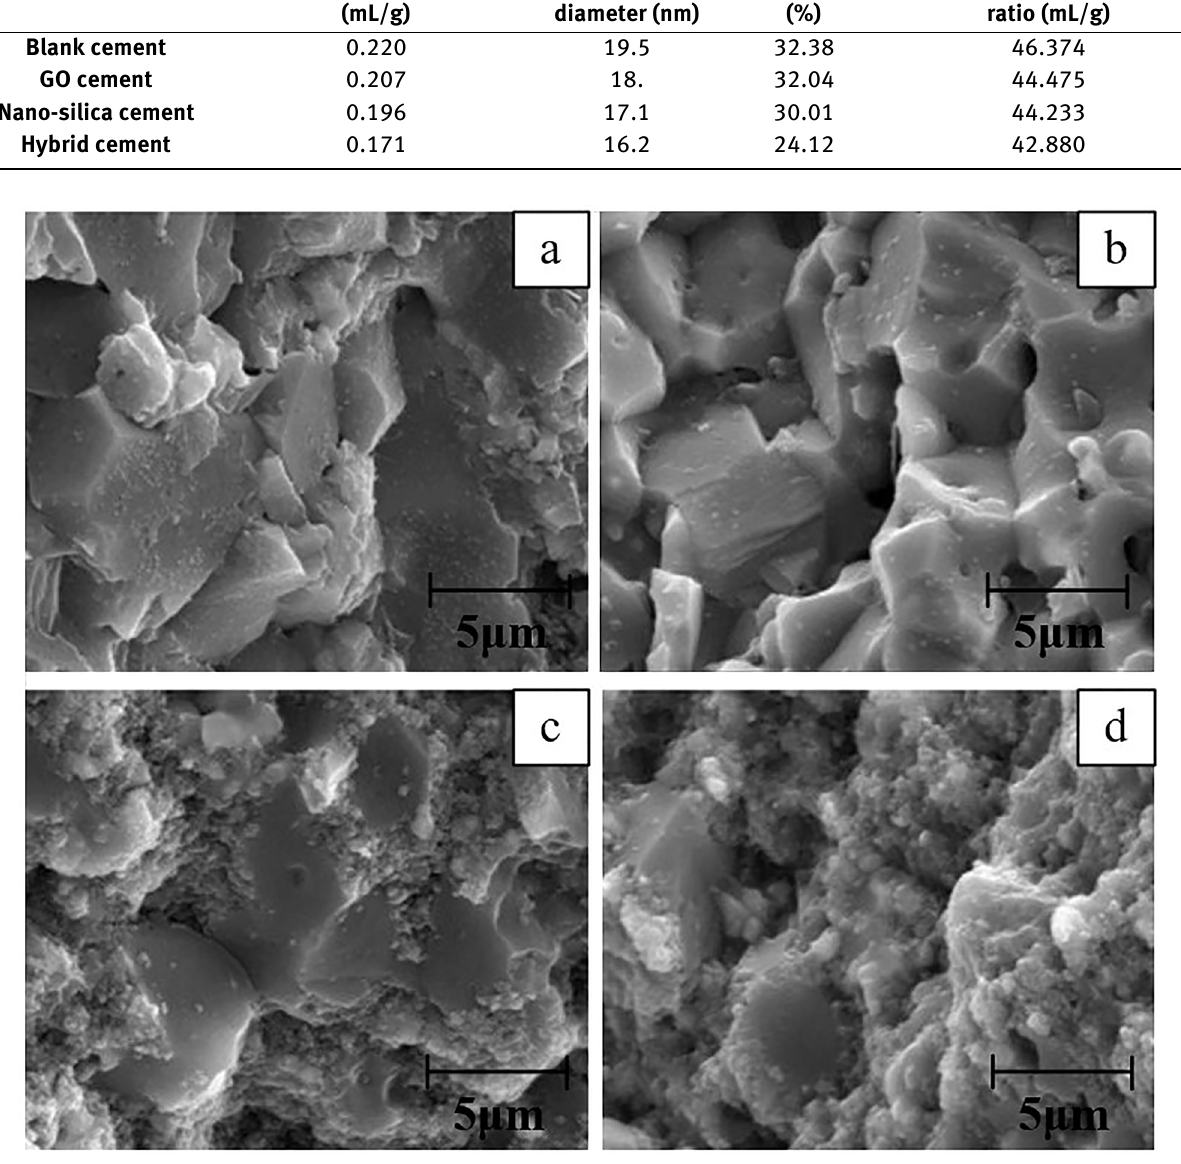
Figure 7: Scanning electron micrographs of the fractured surface of nano-micro composite self-lubricating ceramic tool material with different content of Al 2 O 3 [11] (a) 0 vol.% nano-Al 2 O 3 , (b) 4 vol.% nano-Al 2 O 3 , (c) 20 vol.% nano-Al 2 O 3 , (d) 40 vol.% nano-Al 2 O